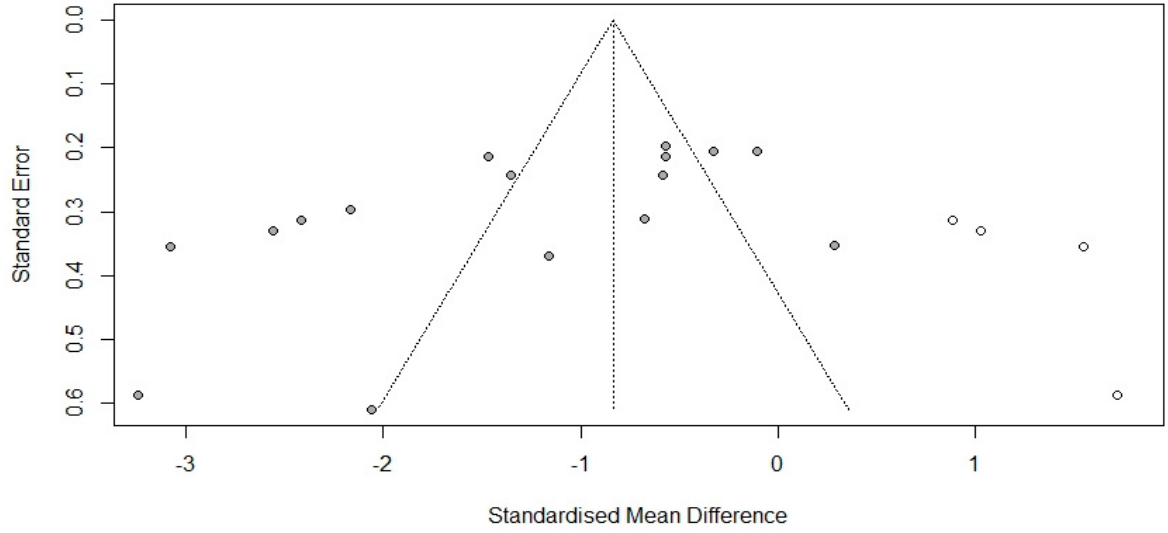
Figure 3. Adjusted funnel plot of Pittsburgh Sleep Quality Index.